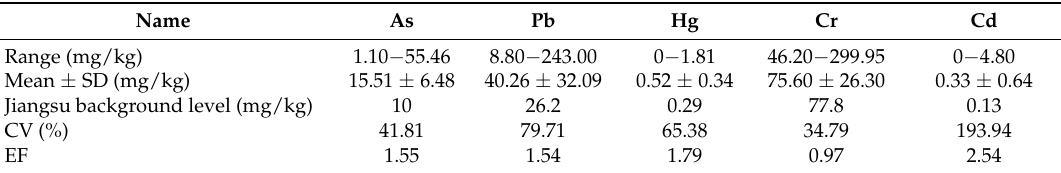
Table 2. Statistical characteristics of the metal concentrations of Suzhou